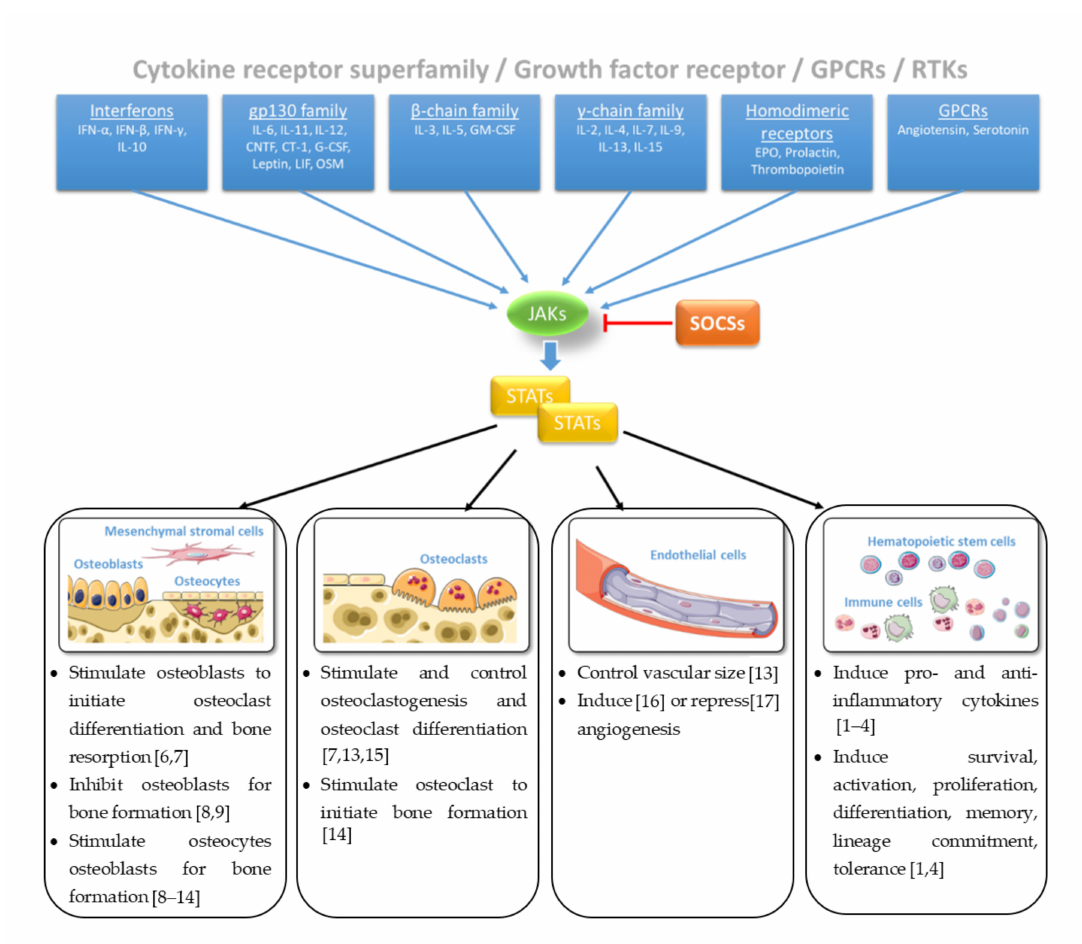
Figure 1. Janus tyrosine kinase (JAK) / signal transducers and activators of transcription (STAT) signaling in bone homeostasis [1–4,6–17]. Figure contains graphics from Servier Medical Art, licensed under a Creative Common Attribution 3.0 Generic License. http: // smart.servier.com /